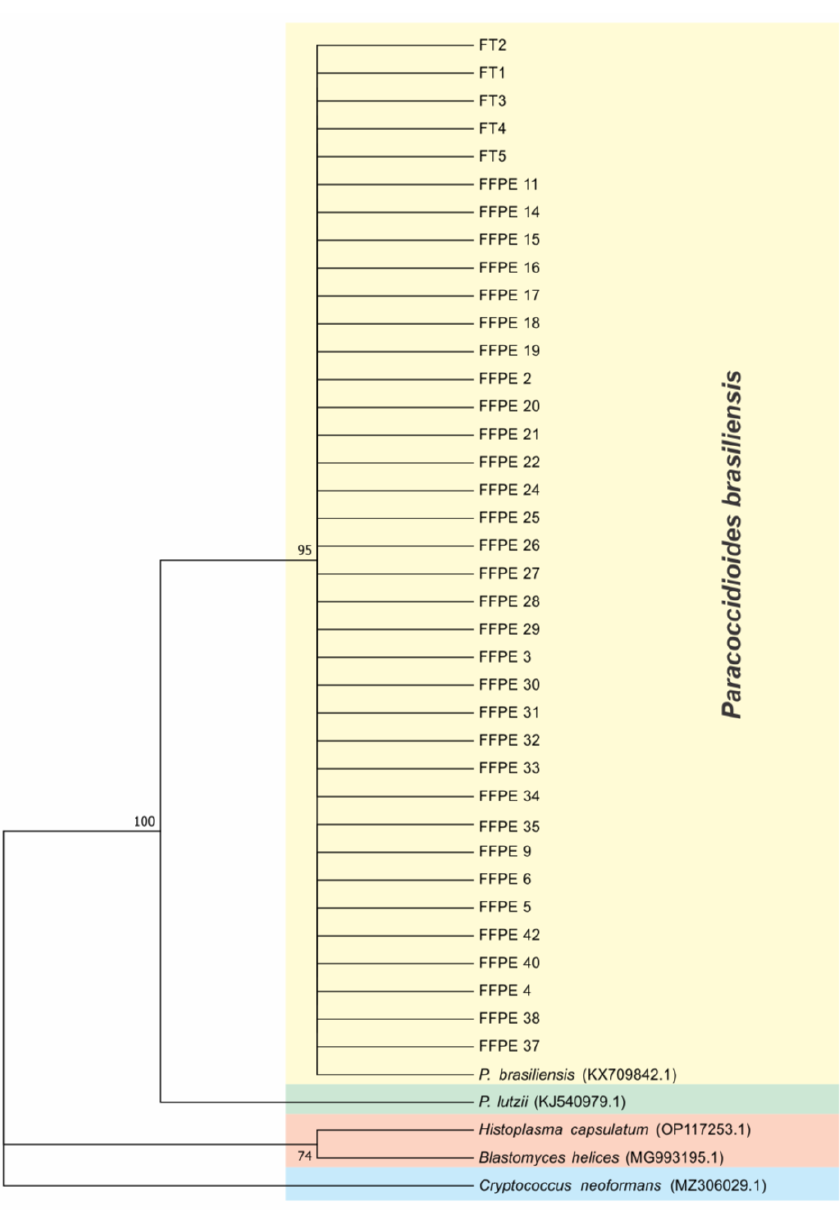
Figure 2. ITS loci phylogenetic tree using Molecular Phylogenetic analysis by Maximum Likelihood method based on the Tamura–Nei model. The tree with the highest log likelihood ( − 702.78) is shown. The percentage of trees in which the associated taxa are clustered together is shown next to the branches. Initial tree(s) for the heuristic search were obtained automatically by applying Neighbor-Join and BioNJ algorithms to a matrix of pairwise distances estimated using the Maximum Composite Likelihood (MCL) approach, and then selecting the topology with superior log likelihood value. The tree is drawn to scale, with branch lengths measured in the number of substitutions per site. The analysis involved 42 nucleotide sequences. All positions containing gaps and missing data were eliminated. There were a total of 263 positions in the final dataset. Evolutionary analyses were conducted in